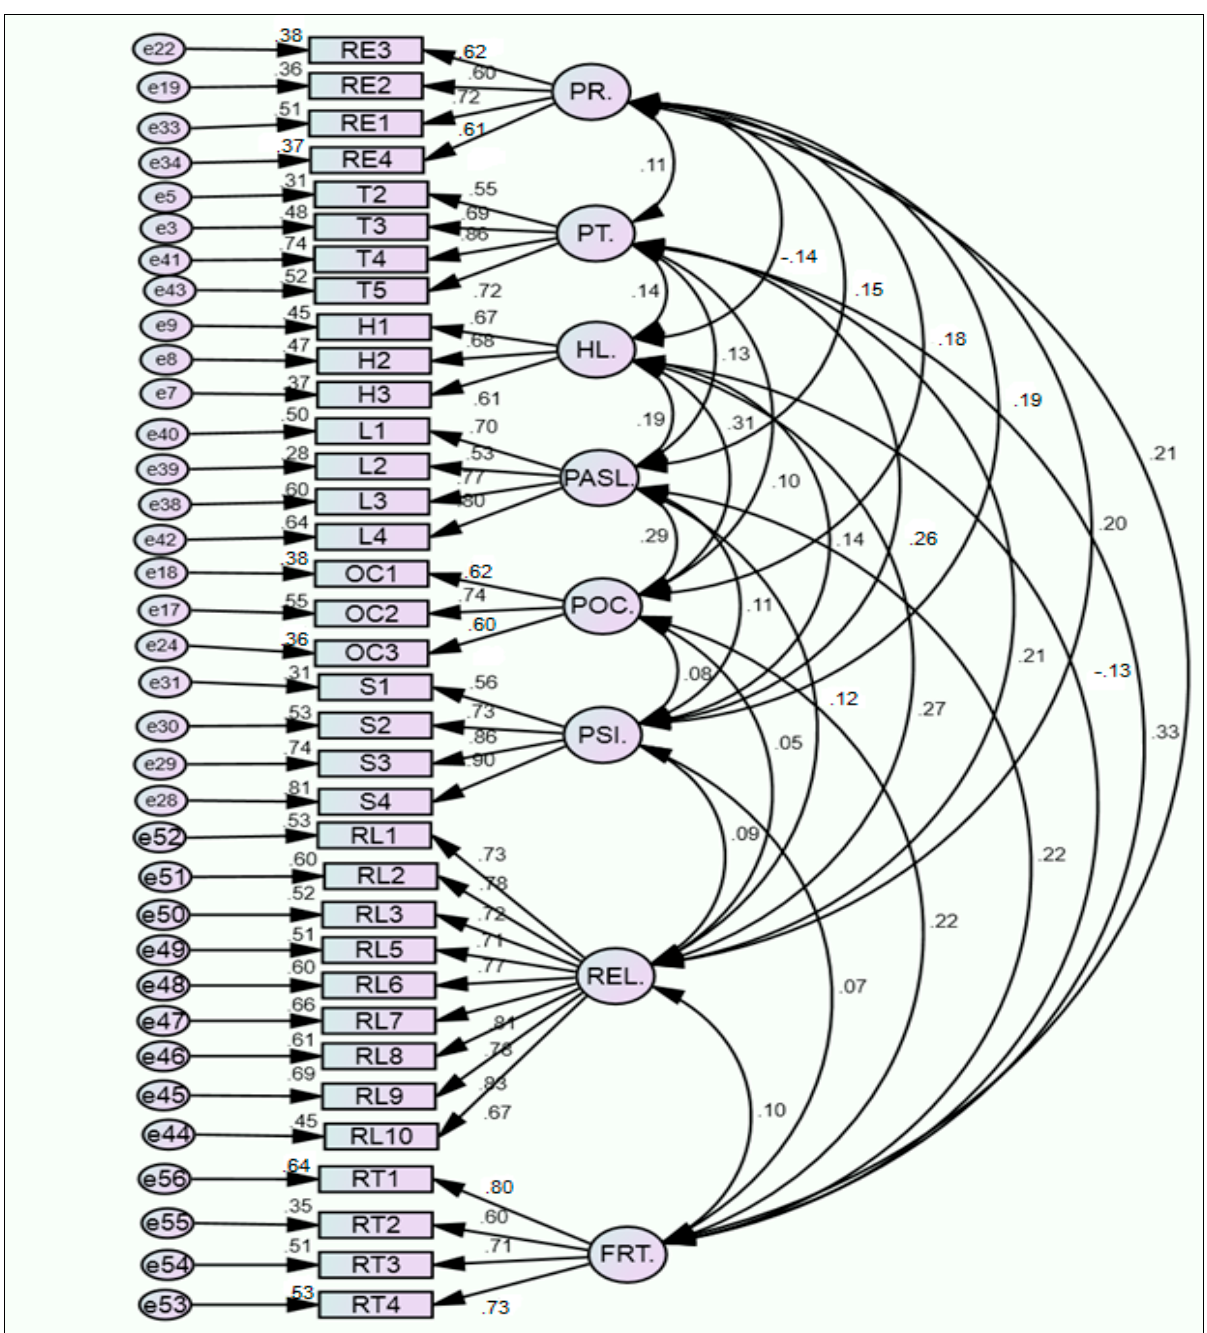
Figure A1. Confirmatory factor analysis results: CFA diagram for independent variables and de- pendent variable. FRT = financial risk tolerance, RL = religiosity, RE = propensity for regret, T = propensity for trust, H = happiness in life, L = propensity to attribute success to luck, OC = propen- sity for overconfidence, S = propensity for social interaction. Table A2. Constructs, items, and code number.